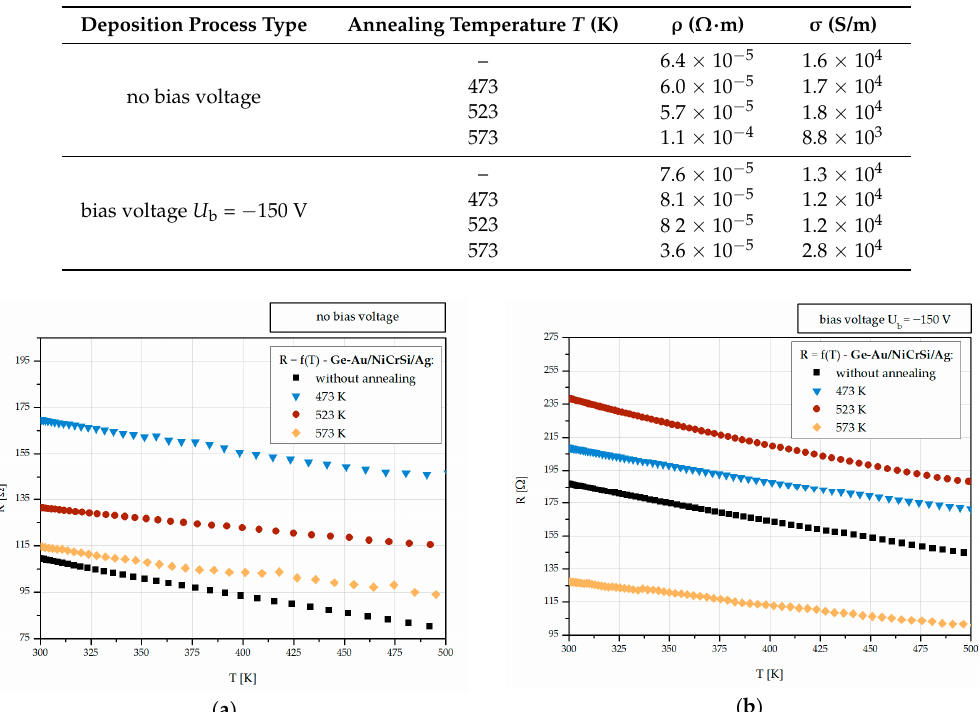
Table 1. Electric properties of the Ge–Au/NiCrSi/Ag test structures: resistivity ρ and conductivity σ at room temperature ( T m = 300 K).